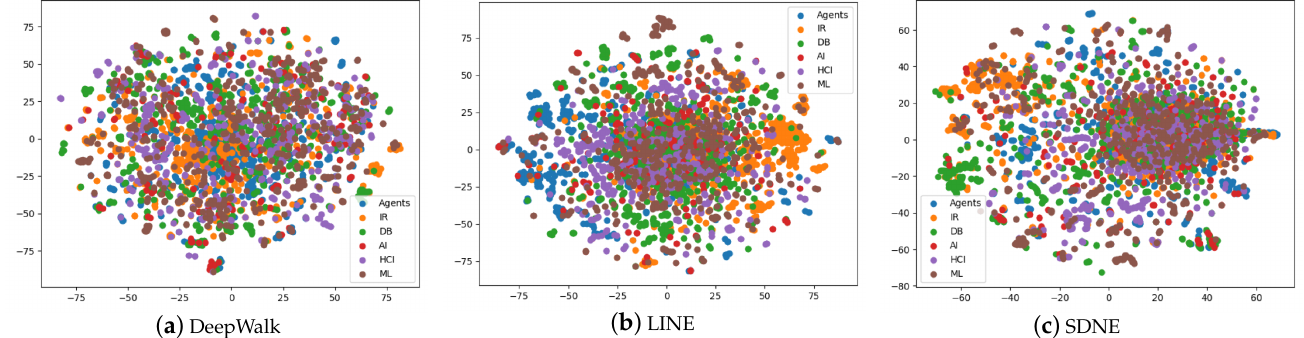
Figure 9. A comparison of the visualization results of the three methods for the Citeseer dataset. ( a ) The result of DeepWalk, ( b ) the result of LINE, and ( c ) the result of SDNE. Differently colored nodes represent different categories. The dataset contains six categories (agents; artificial intelligence (AI); database (DB); information retrieval (IR); machine language (ML); human–computer interaction (HCI)).